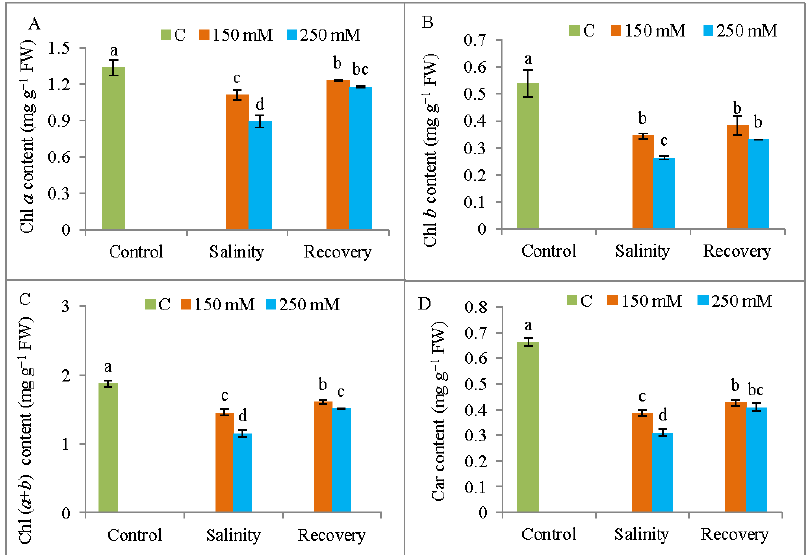
Figure 6. Photosynthetic pigments contents ( A ) chlorophyll a (Chl a ), ( B ) chlorophyll b (Chl b ), ( C ) Chl ( a + b ), and ( D ) carotenoid in tomato plants under salinity (150 and 250 mM NaCl) and after a 48 h recovery period. Data means (±SD) were calculated from three replications. Statistically significant values are indicated by dissimilar letters (Fisher’s LSD test, P ≤ 0.05).